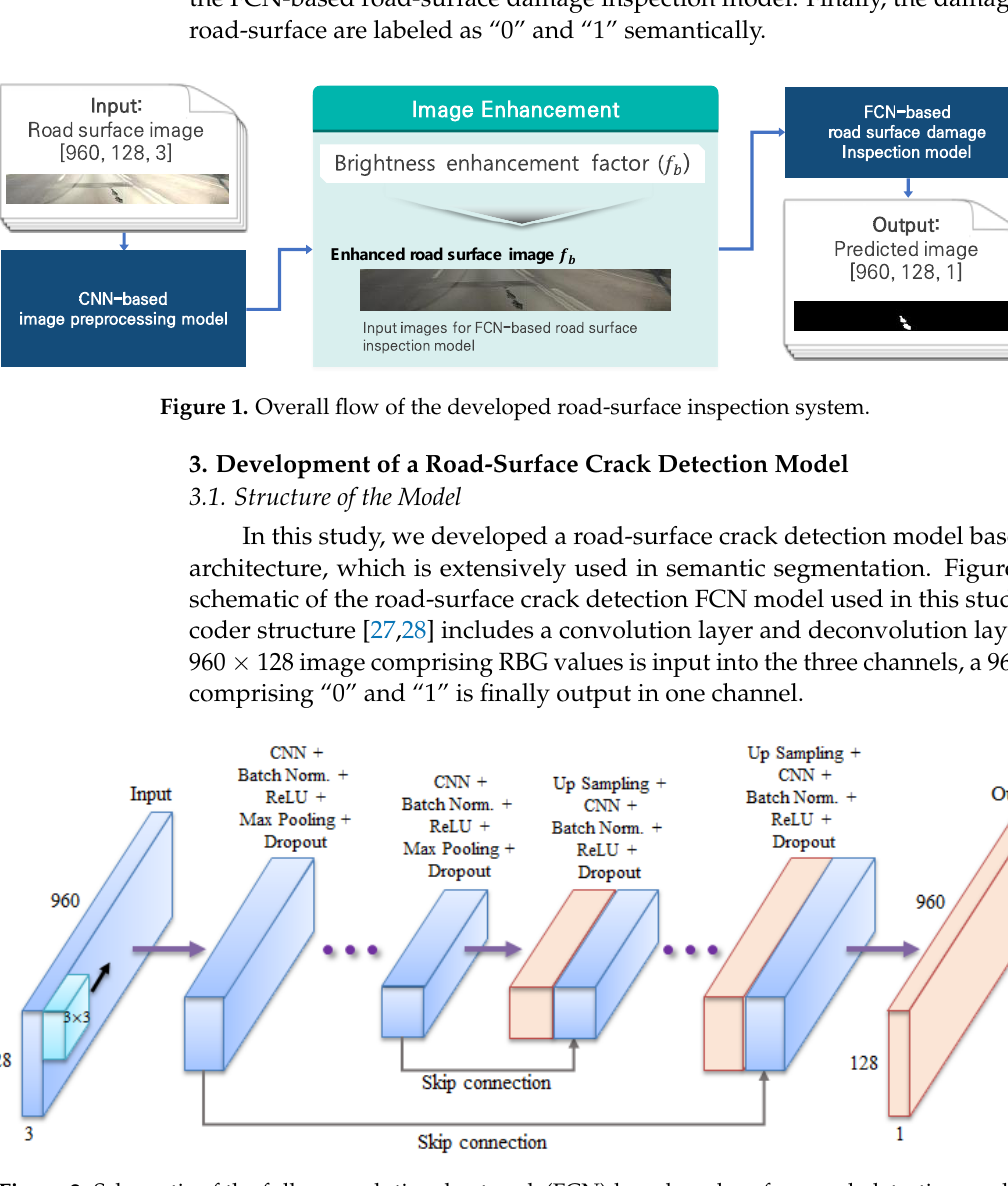
Figure 2. Schematic of the fully convolutional network (FCN)-based road-surface crack detection model. A total of five FCN model structures with four, six, eight, ten, and twelve hidden layers excluding the input and output layers, respectively, were tested to select the final FCN model. In all the models, the convolution layers constituted half of the total hidden layers, whereas the deconvolution layers constituted the other half. The kernel size used in all the models was (3, 3). After zero padding, the composite product was multiplied by a stride of (1, 1). The number of kernels was 16 in the first convolution layer of each model, which increased by double each time it moved to the next layer. A batch normalization technique [29] was applied before passing the ReLu (rectified linear unit) [30], which was used as the activation function of the hidden layer. After applying the activation function to the convolution layer, the result was max-pooled with a size of (2, 2). In the deconvolution layer, up-sampling was performed using a (2, 2) filter before performing convolution, and the convolution layers at the symmetrical position were connected through skip connections. A dropout rate of 0.2 was applied during the learning of all the hidden layers. In the output layer, sigmoid was designated as the activation function, and the resulting value for each pixel was classified as “0” and